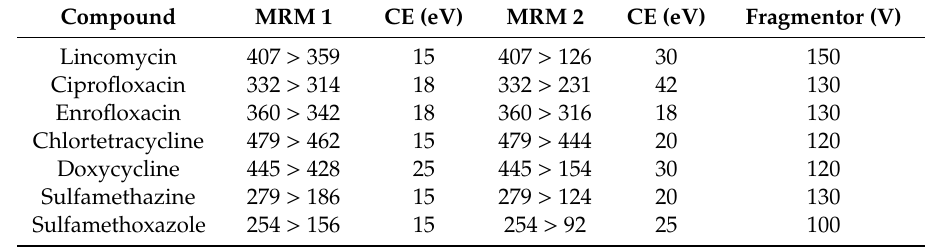
Optimized multiple reaction monitoring (MRM) conditions for the analysis of the selected